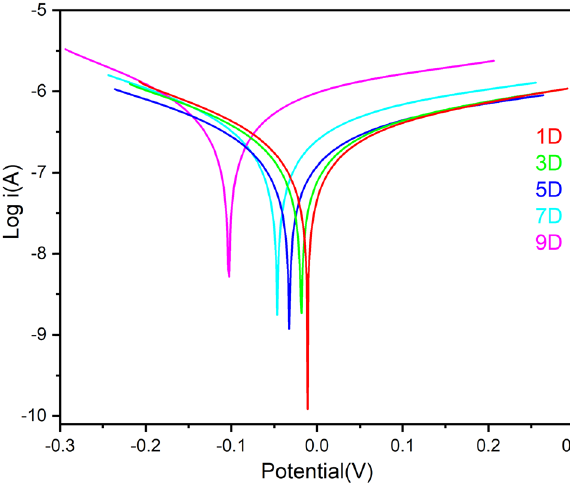
Figure 7: Tafel plot of ROGAU - coated